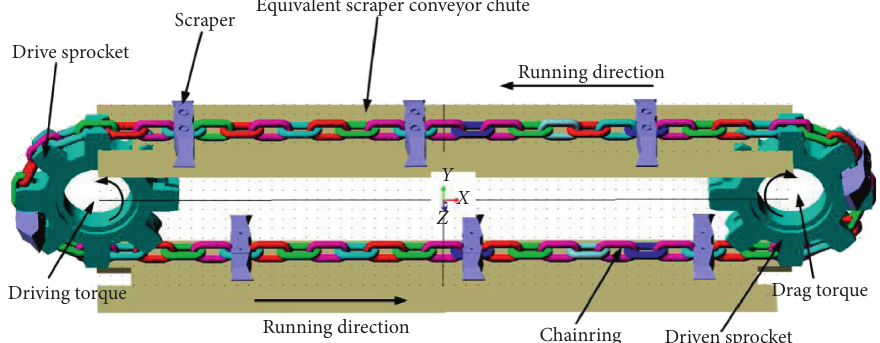
Figure 3: Simplified chain transmission system model.